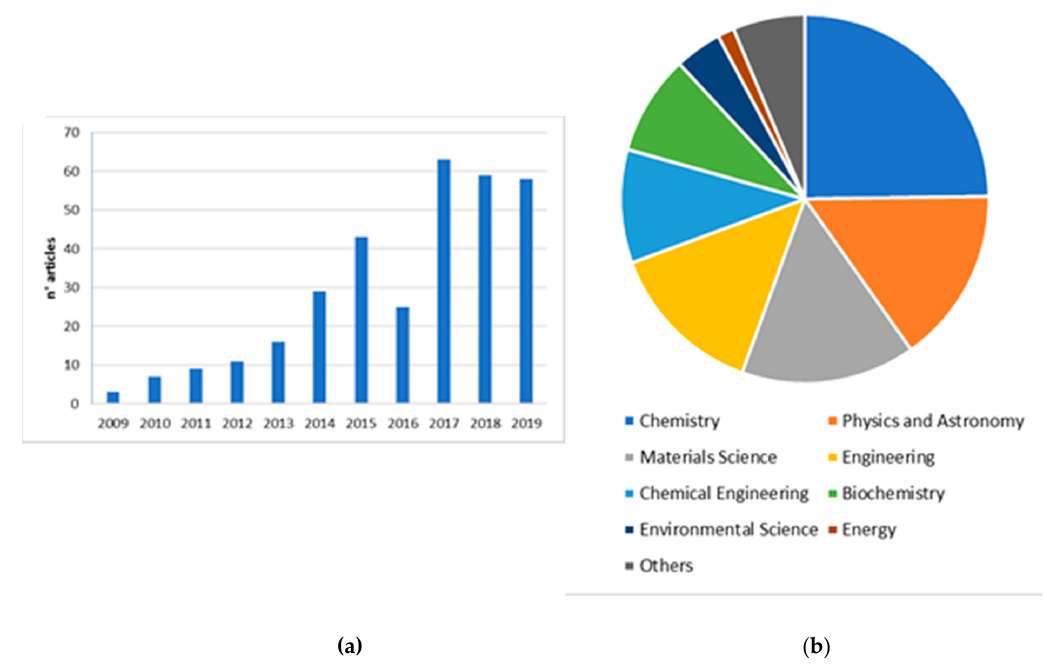
Figure 1. Data from Scopus.com in the last 10 years (2009–2019) for the keywords “silver nanoparticles as colorimetric sensors”: ( a ) Number of publications per year; ( b ) Subjects areas involved in this research field.